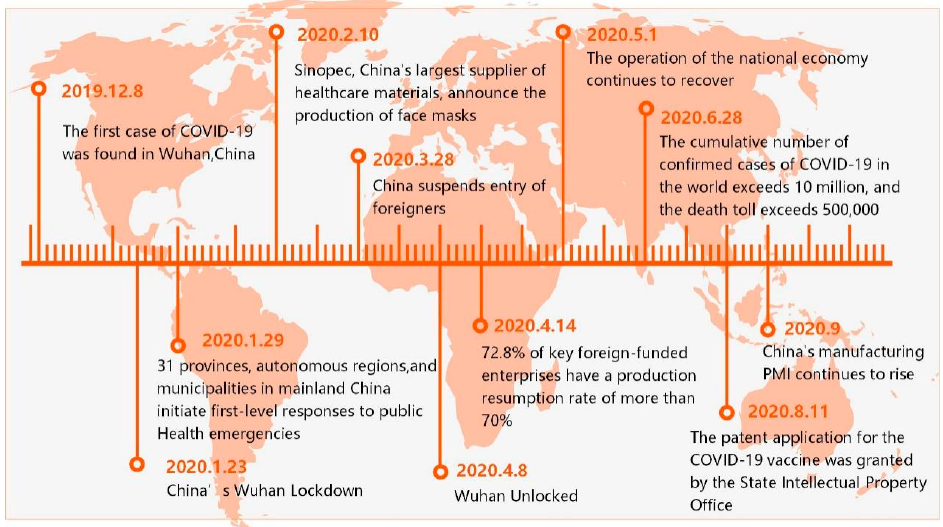
Figure 2. Key events of the COVID-19 pandemic.